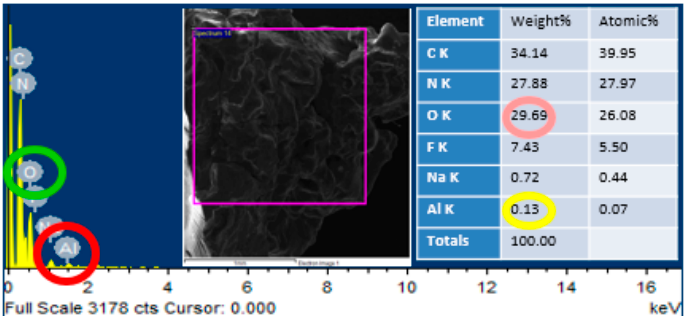
Figure 5. EDS analysis of pure urea-formaldehyde resin.